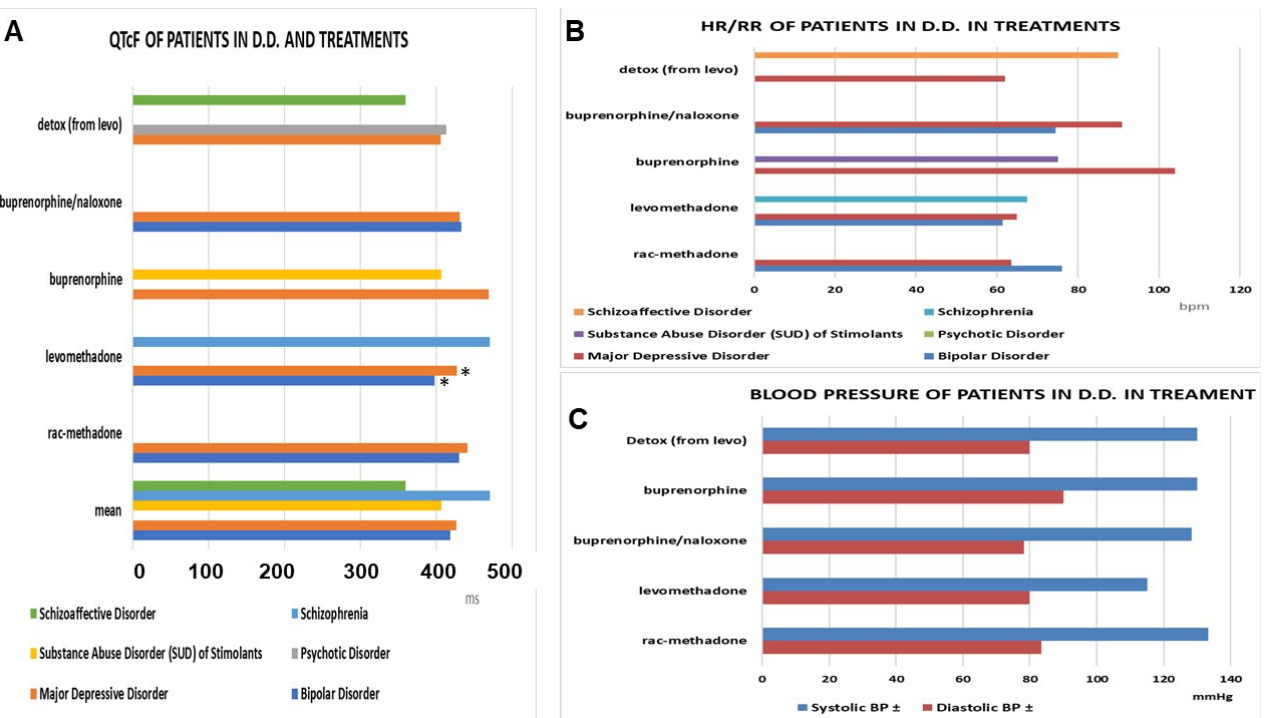
Figure 7. ( A ) The QTcF in the double diagnosis patients under maintenance treatments. Levomethadone showed the lowest values in bipolar patients and major depressive disorders (*) vs. other treatments (data significantly different * ANOVA one-way F > 2.5 p < 0.05), and the highest values in the schizophrenia patients, due to the inclusion of one congenital QT case. ( B , C ) Cardiovascular parameter in the double diagnosis (D.D.) patients under maintenance treatments. HR = heart rate, RR = intervals of the ECG.